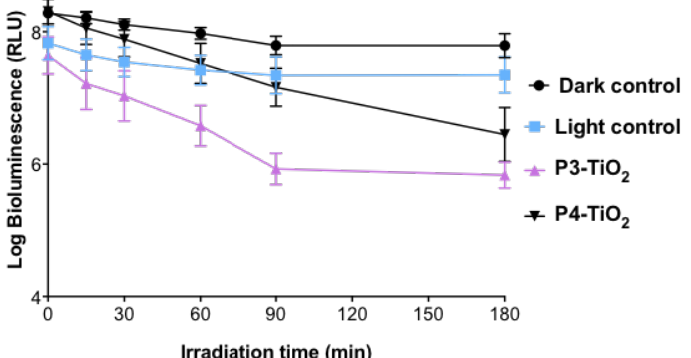
Figure 10. Photoinactivation of the bioluminescent E. coli in the presence of porphyrins P2 , P3 and P4 supported on chitosan at the concentration of 3.0 µ M under 3.0 mW cm − 2 of white light irradiation. The values represent the mean of three independent experiments with three replicates and the error bars indicate the standard deviation.